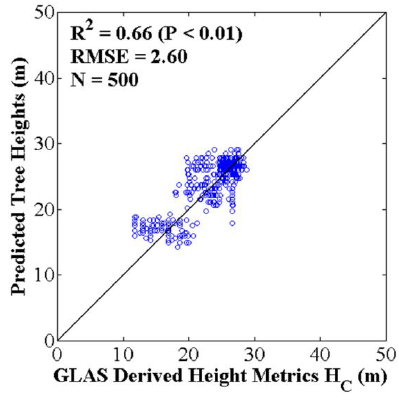
Figure 8. Bootstrapping evaluation of the optimized ASRL model. The optimized model used the best GLAS tree height metric ( H in Figure 5(c)). 100 sets of bootstrapping C subsamples were generated for five eco-climatic